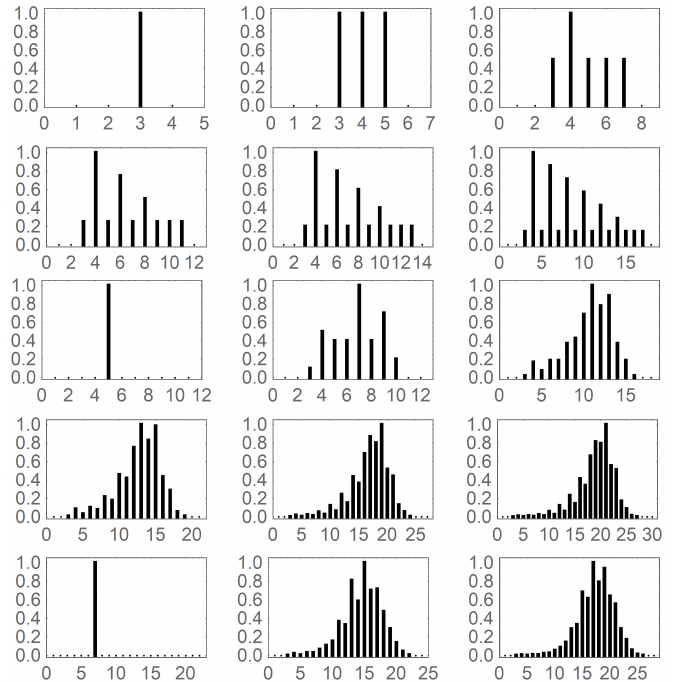
Figure 23. The normalized cycle spectrum for products of two odd primes. The top two rows are p = 3 q , where q = 3,5,7,11,13,17. The third and fourth rows are p = 5 q , where q = 5,7,11,13,17,19. The final row is p = 5 q , where q = 7,11,13.